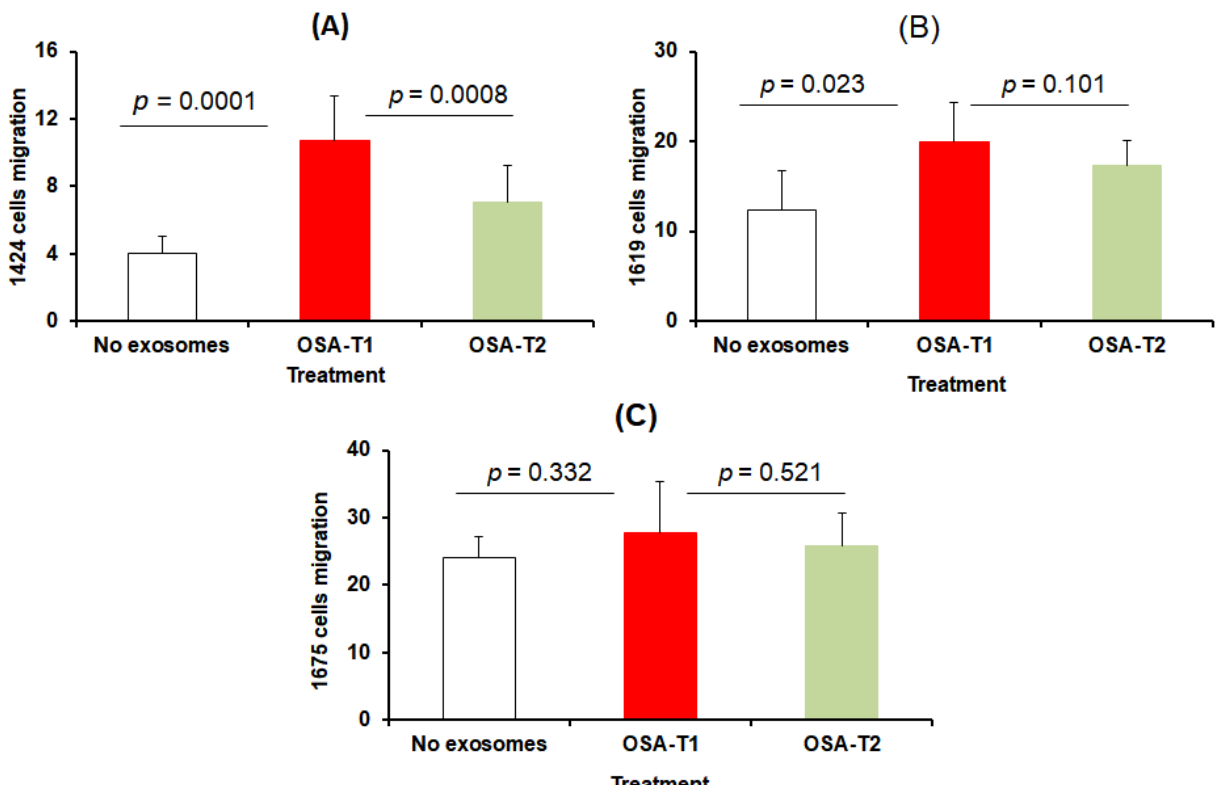
Figure 3. Effects of plasma exosomes-derived from OSA patients before CPAP treatment (OSA-V1) and after adherent CPAP treatment for 1 year (OSA-V2) on melanoma cell migration. Cells were seeded in 24-well trans-well inserts with 8 μm pore size. Cells were allowed to migrate for 40 h, and then were stained with 0.2% crystal violet solution followed by phase contrast imaging. The migration rate was determined by counting the number of cells contained in the photos of 5 different fields at original magnification. ( A ) represents average of different fields for each subject for each group using CRL-1424 cells, ( B ) CRL-1629, and ( C ) CRL-1675, ( n = 20/group), with statistical significance set at p < 0.05.